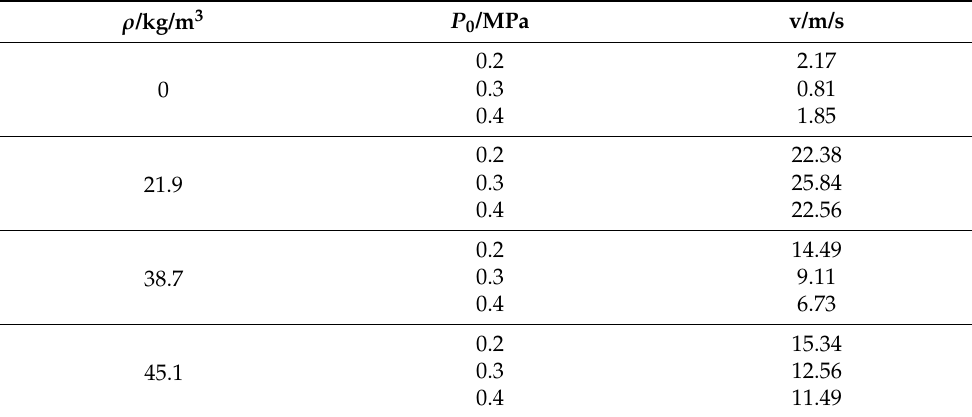
Table 4. Average flame tip velocities at different filling